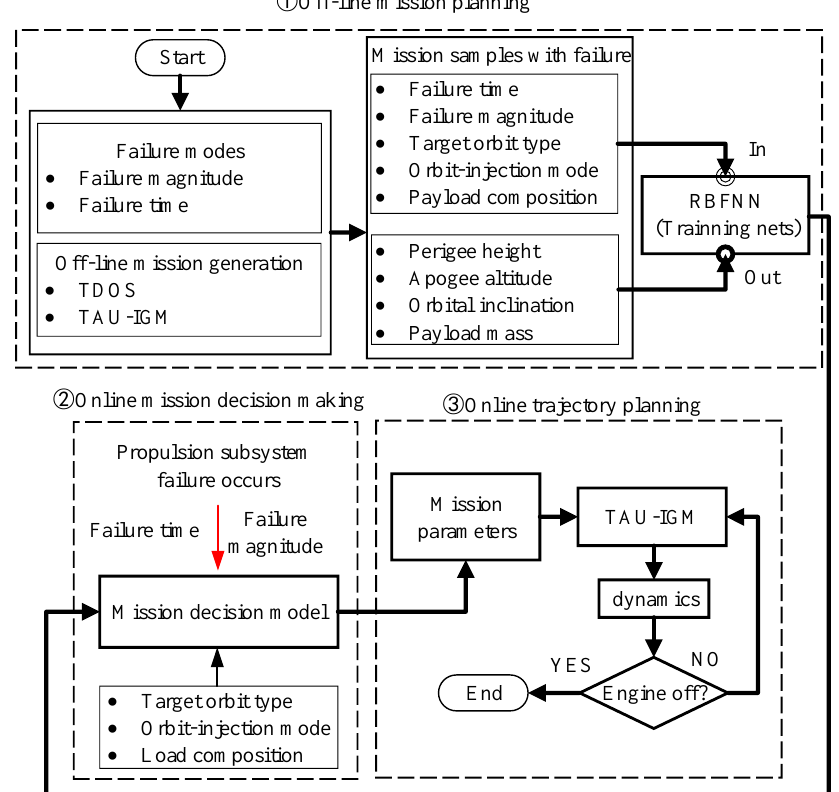
Figure 3. Launch vehicle trajectory-planning method.